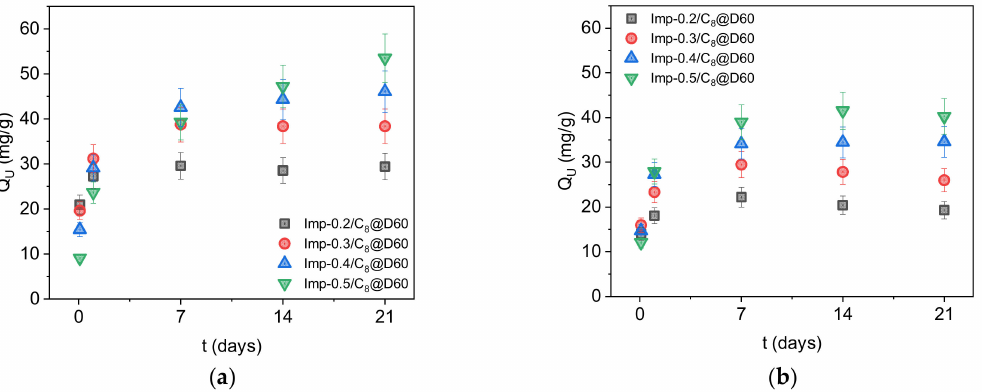
Figure 6. Uranium extraction capacity of the four functionalized materials with different ligand concentrations after 2 h and 1, 7, 14 and 21 days in sulfuric acid solutions ([SO 4 ] 2 − /[U] = 900 mol/mol) ( a ) in the absence and ( b ) in the presence of competing cations (Fe and